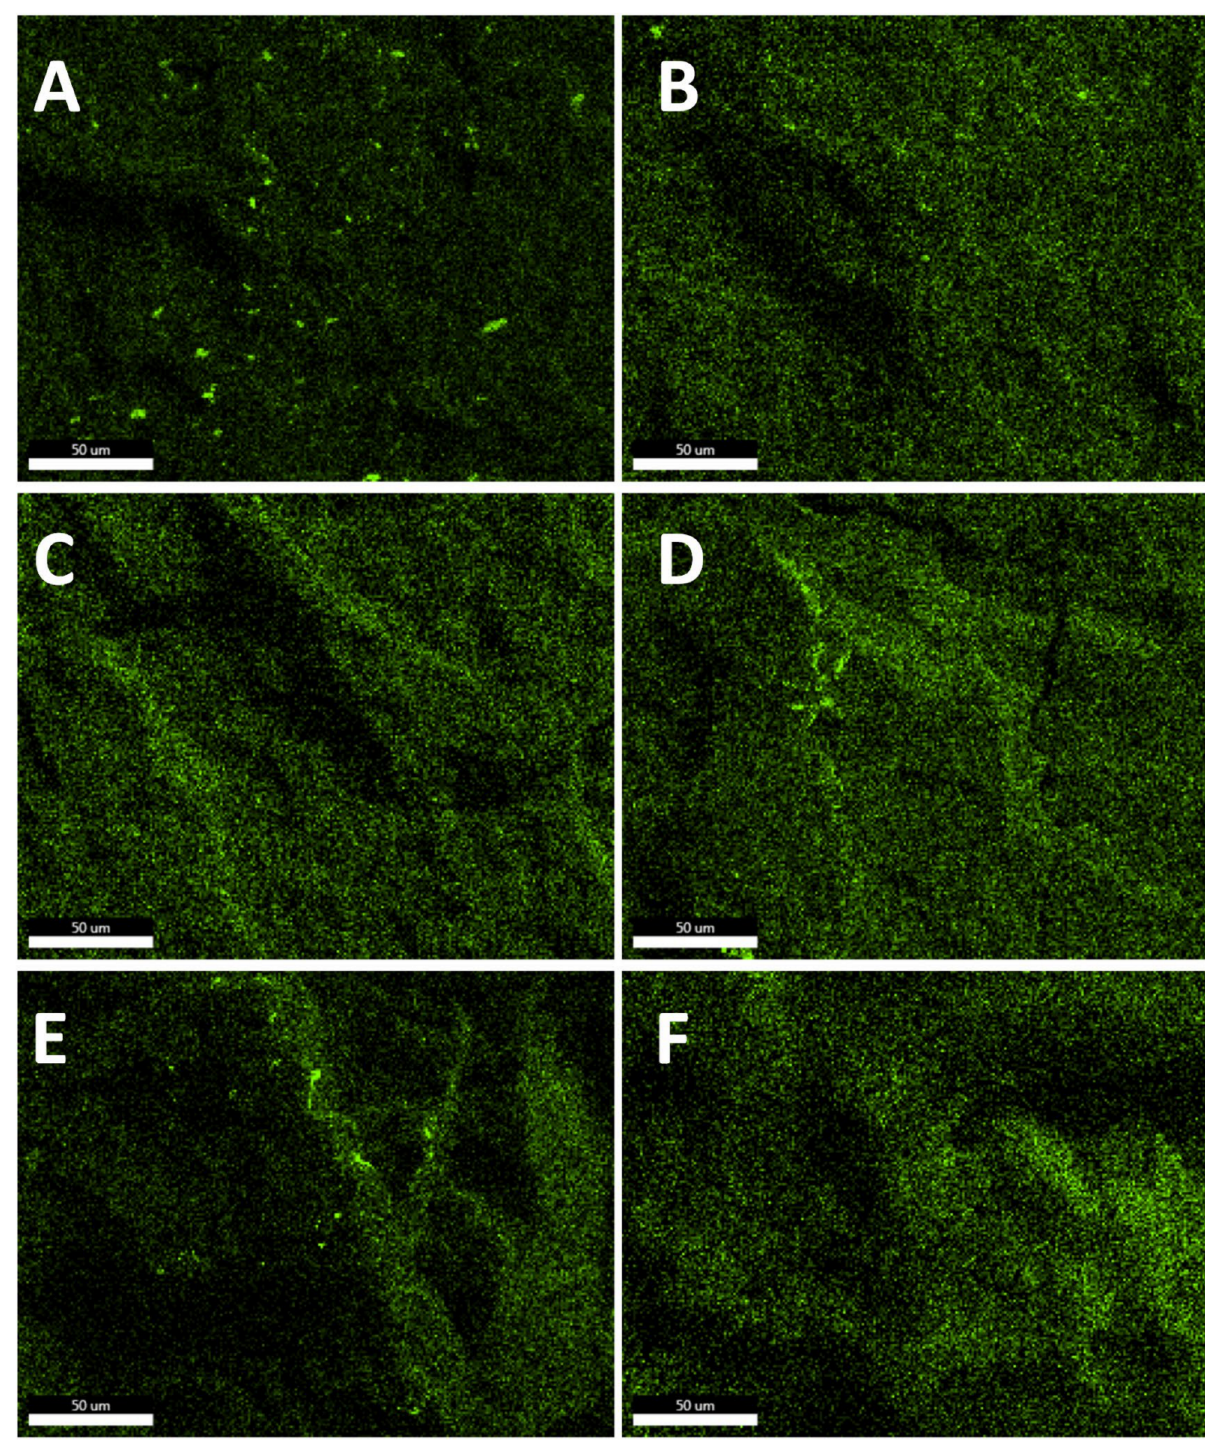
Figure 4. Oxygen EDS images of 1% CS/iPP composites. ( A )—SS-Glycidyl, ( B )—SS-Limonene, ( C )— i Bu 7 SSQ-3OH, ( D )— i Bu 7 SSQ-Cl, ( E )— i Bu 7 SS-Vi, ( F )— i Bu 7